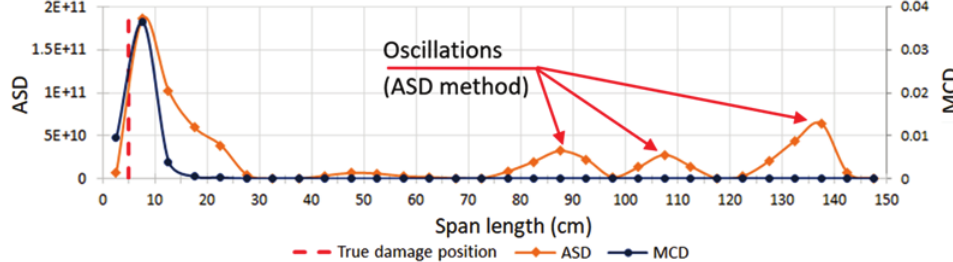
Figure 12 Comparison of the results obtained by ASD and MCD methods for the model with only one damage